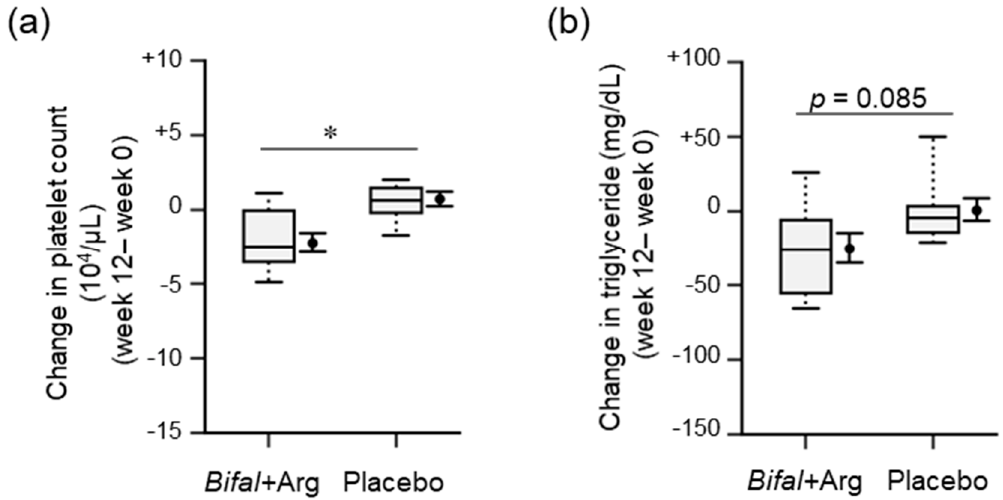
Figure 3. Effect of the consumption of yogurt containing B. animalis subsp. lactis and Arg (Bifal + Arg YG) on platelet count and blood triglyceride. Boxplots represent the 5th percentile, 95th percentile, interquartile range (25–75%), and median. The black circle and error bars on the side of the boxplots represent the average value and SEM, respectively. ( a ) Change in platelet count during the clinical test period. * p < 0.05, baseline × change interaction p = 0.111 by two-way ANOVA). n = 18 in the Bifal + Arg YG group and n = 16 in the placebo group. ( b ) Change in triglyceride level during the clinical test period ( p = 0.085, baseline × change interaction p = 0.061 by two-way ANOVA). n = 18 in the Bifal + Arg YG group and n = 14 in the placebo group (two outliers in the placebo group were detected; Supplementary Figure S3).